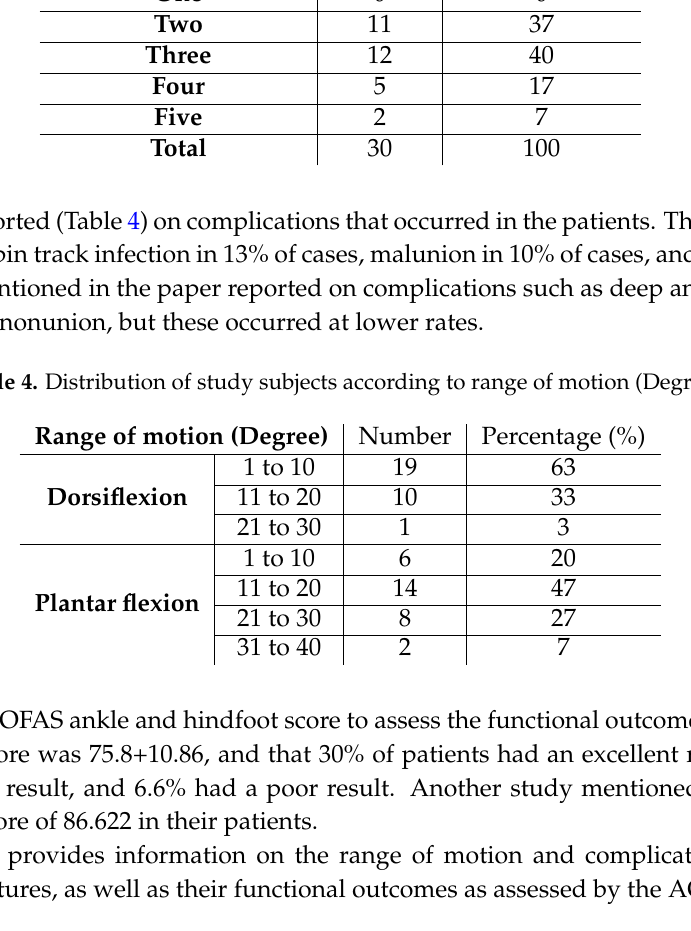
Table 3. Distribution of study subjects according to clinical union time (months) Union Time (Months)